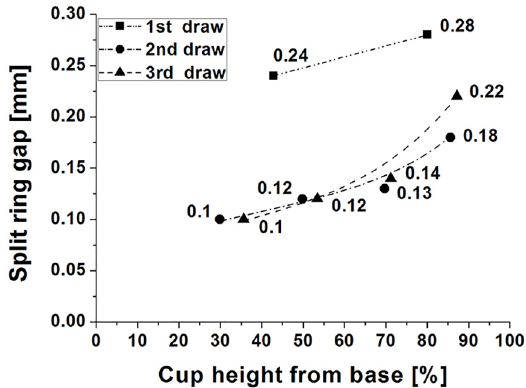
Figure 9. Schematically showing of spring back behaviour of cup walls in terms of split ring gaps (1 st -2 nd -3 rd draw). draw steps, which perhaps due to decrease in residual hoop stresses on cup walls, caused by increasing predominance of wall ironing 26 in second and third draw